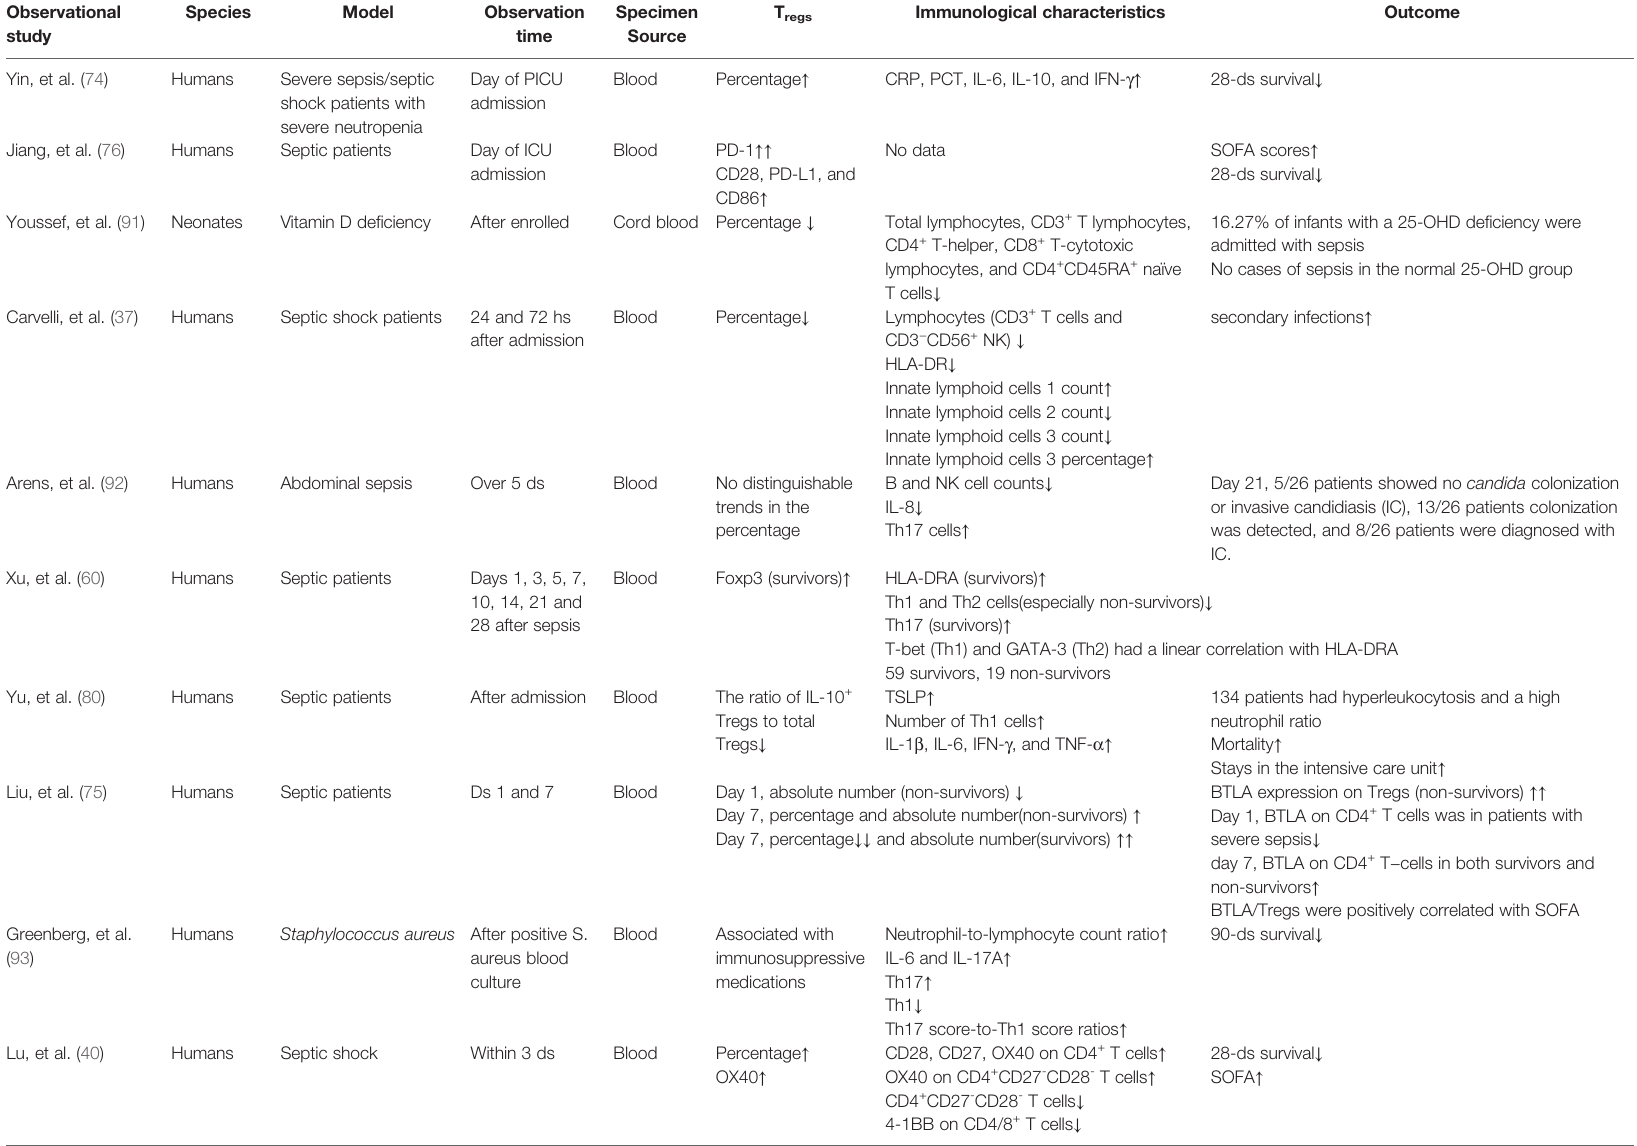
TABLE 2 | Observational studies using septic patients or combined animal models focused on the characteristics of T regs in